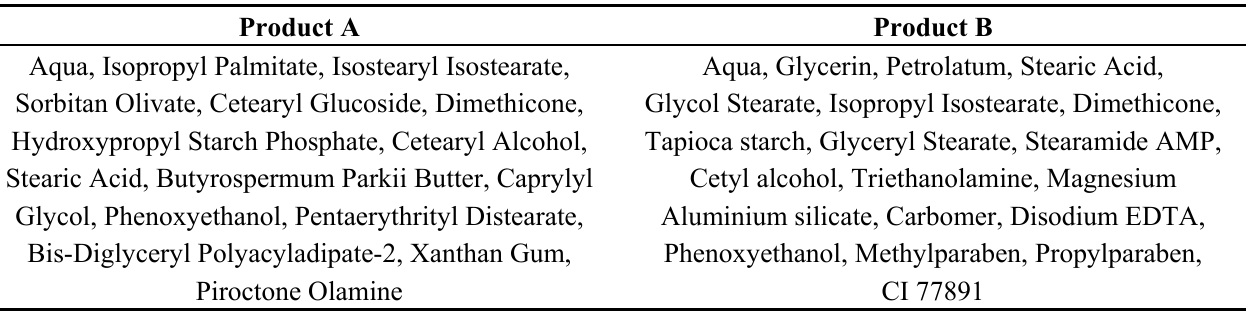
Table 1. Constituents of the formulations used in the clinical